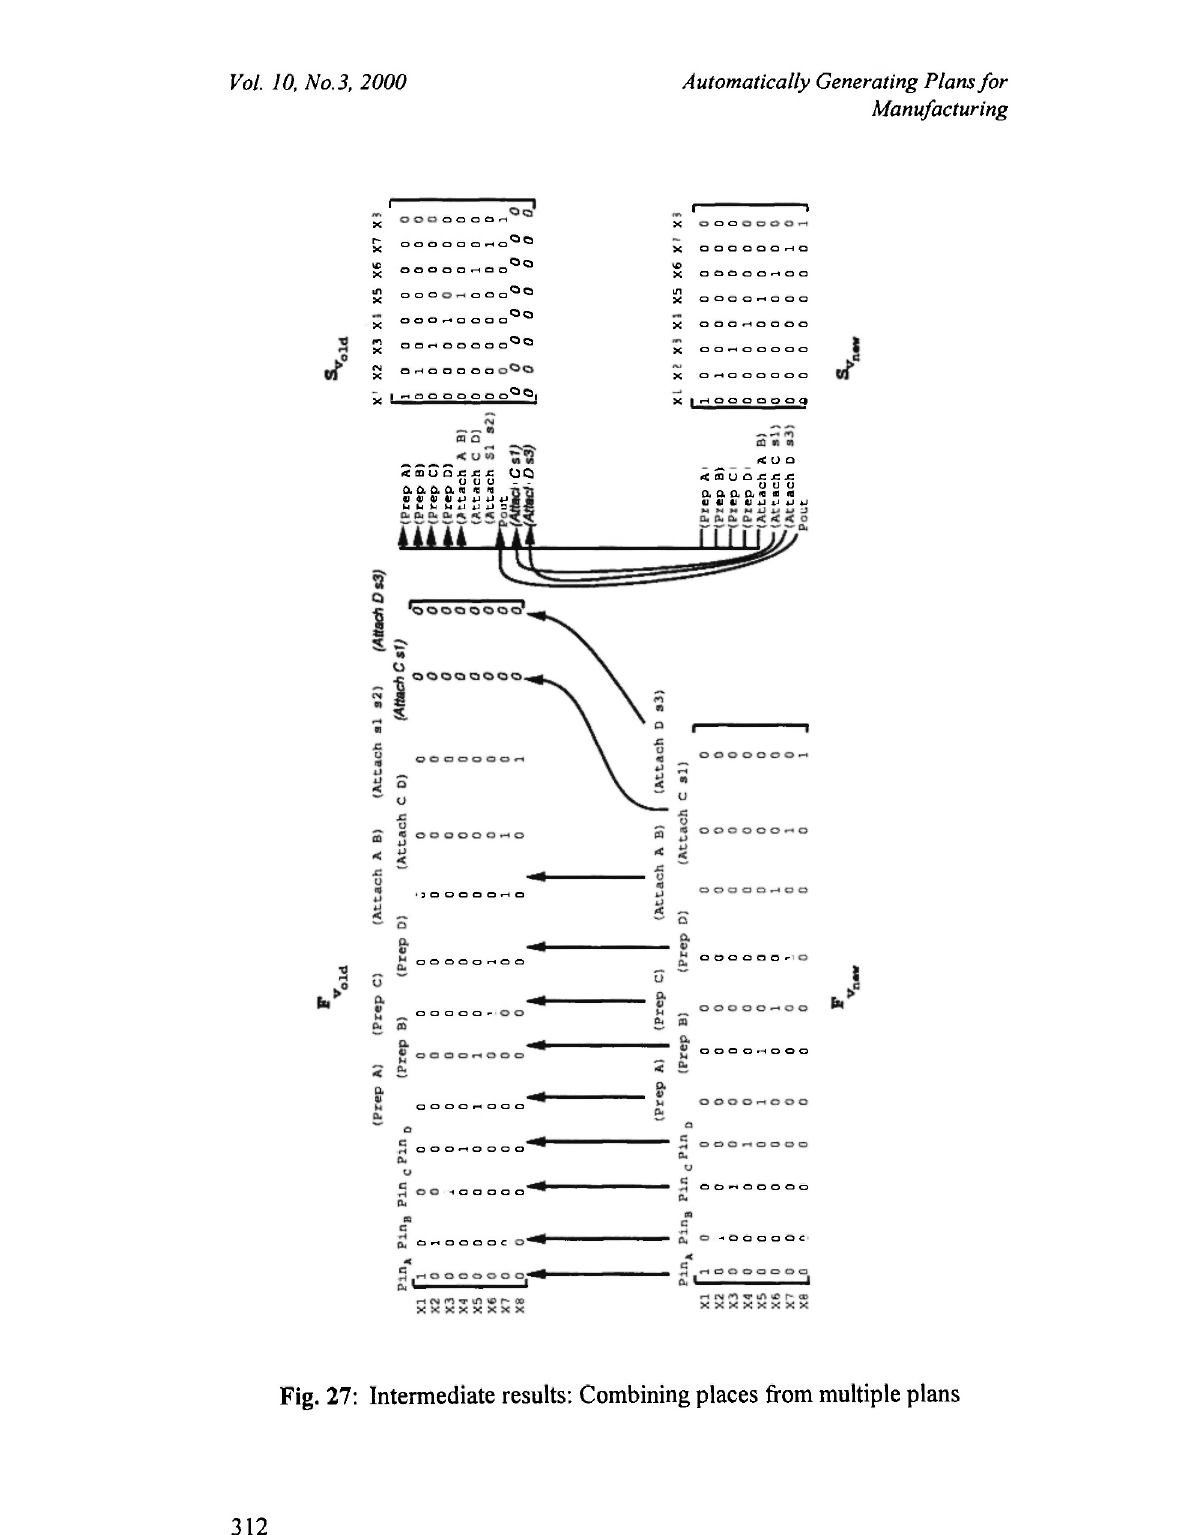
Fig. 27: Intermediate results: Combining places from multiple plans